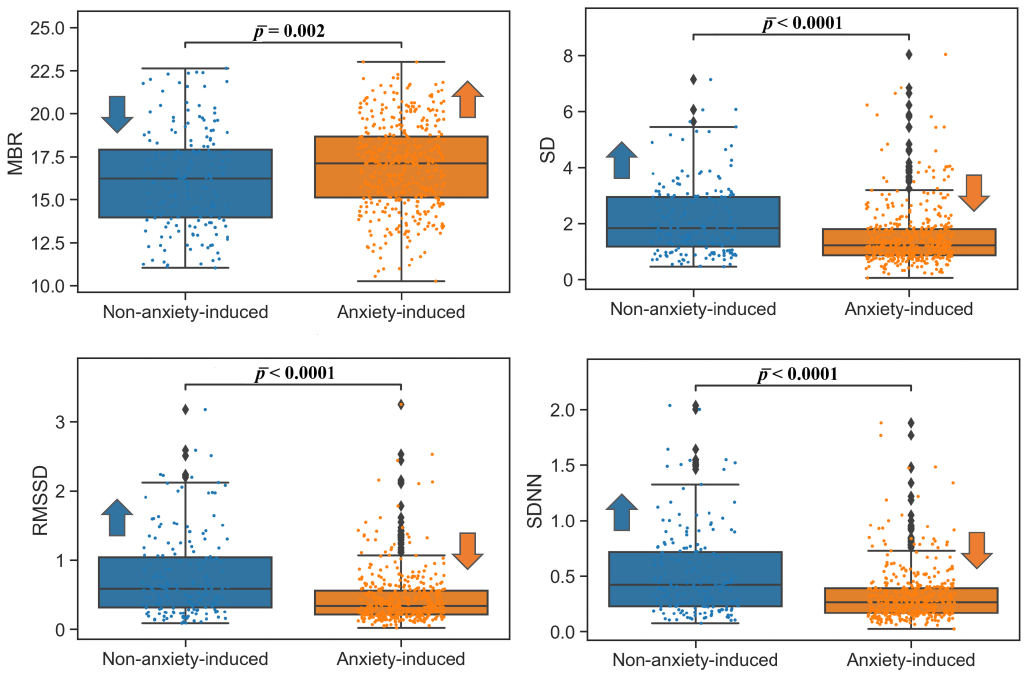
Figure 3. Time domain RSP box plots nontransitional video phases. Mean breathing rate: MBR (bpm); standard deviation of the breathing rate: STDBR; root mean square of successive difference: RMSSD; standard deviation of NN intervals: SDNN. Arrows indicate which of the two populations (non-anxiety-induced state or anxiety-induced state) had a higher (upward arrow) or lower (downward) value for ease of